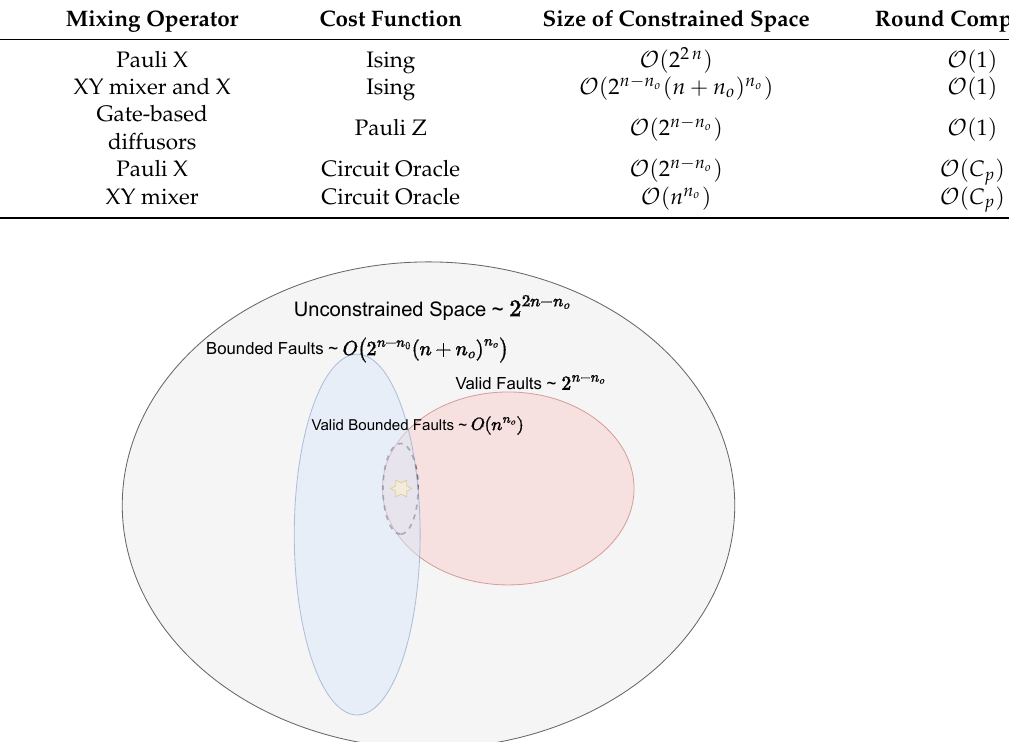
Figure 2. A visual representation of the subspaces that the wave function is kept within during evolution through each QAOA